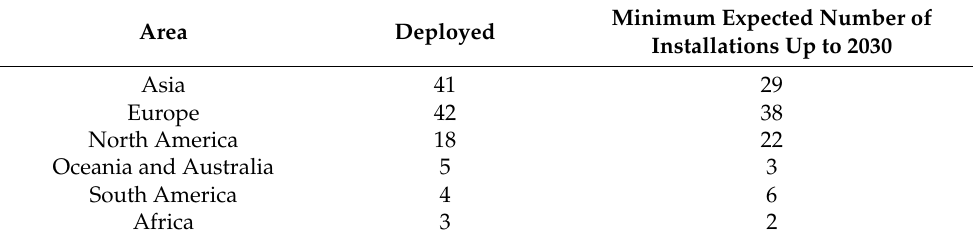
Minimum Expected Number